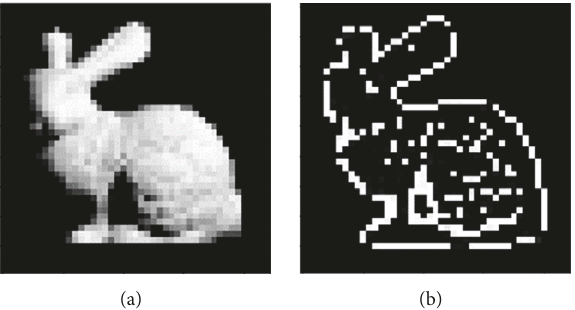
Figure 10: Source and normalized images of rabbit (CVs). The original colour image was provided by Prof. Lee by a personal